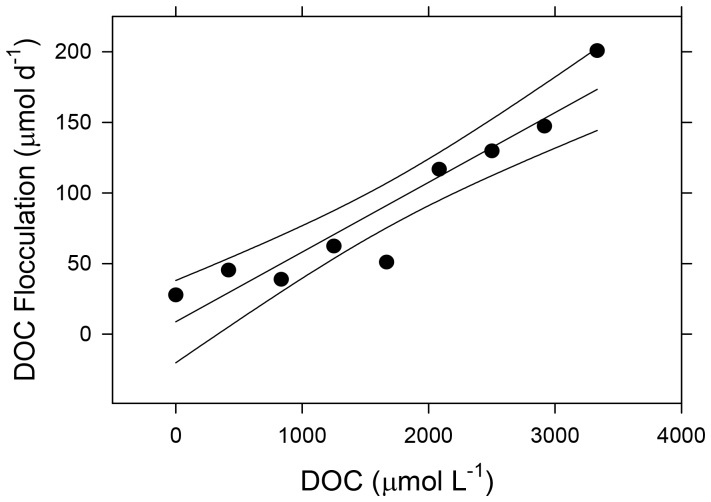
Flocculation rates of Super Hume.We estimated flocculation rates in laboratory assays as the loss of dissolved organic carbon (DOC) at different Super Hume concentrations added to water from a reference pond. Regression lines represent predicted values and 95% confidence intervals.